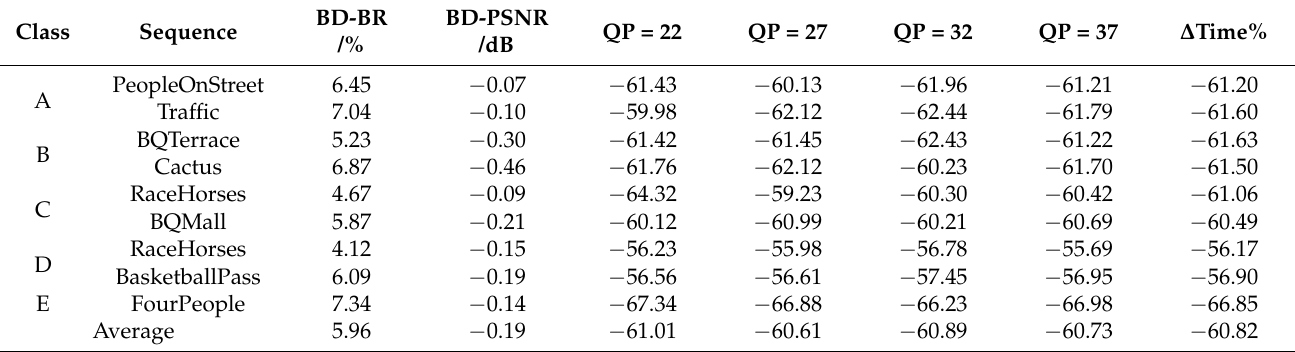
Table 4. Time-saving comparison between this algorithm and